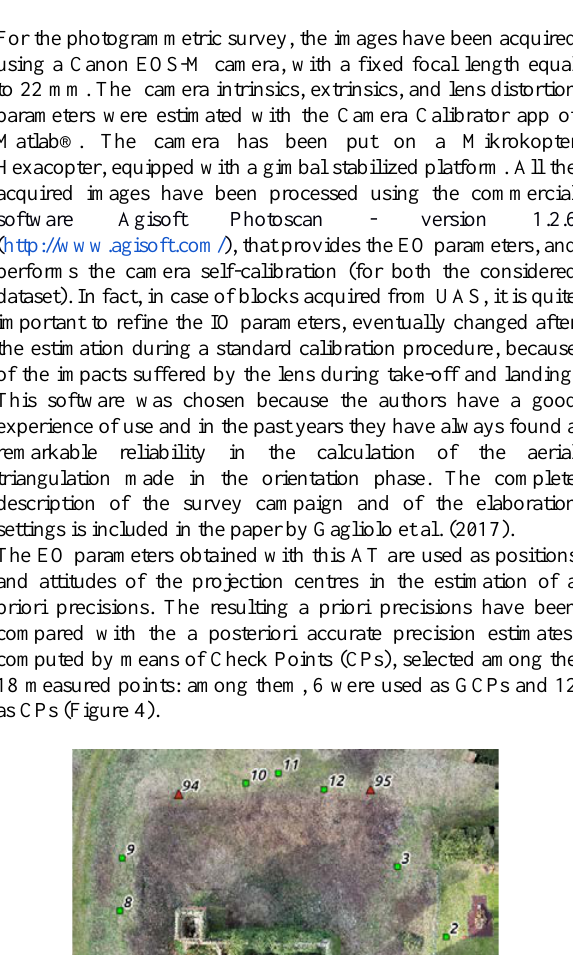
Figure 3. The castle of Casalbagliano in its 3D